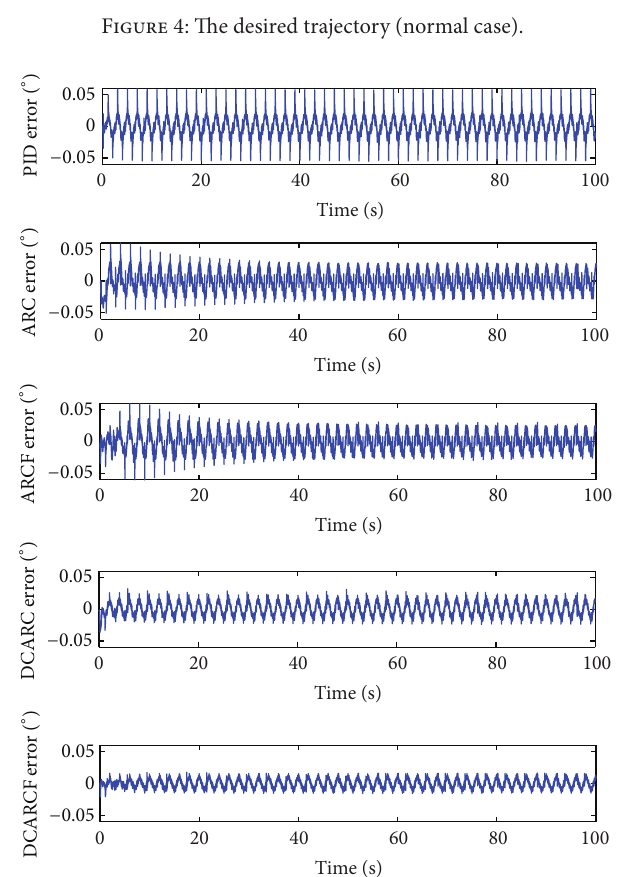
Figure 5: Tracking errors of five controllers in normal case, PID, ARC, ARCF, DCARC, and DCARCF, from top to bottom, respec-